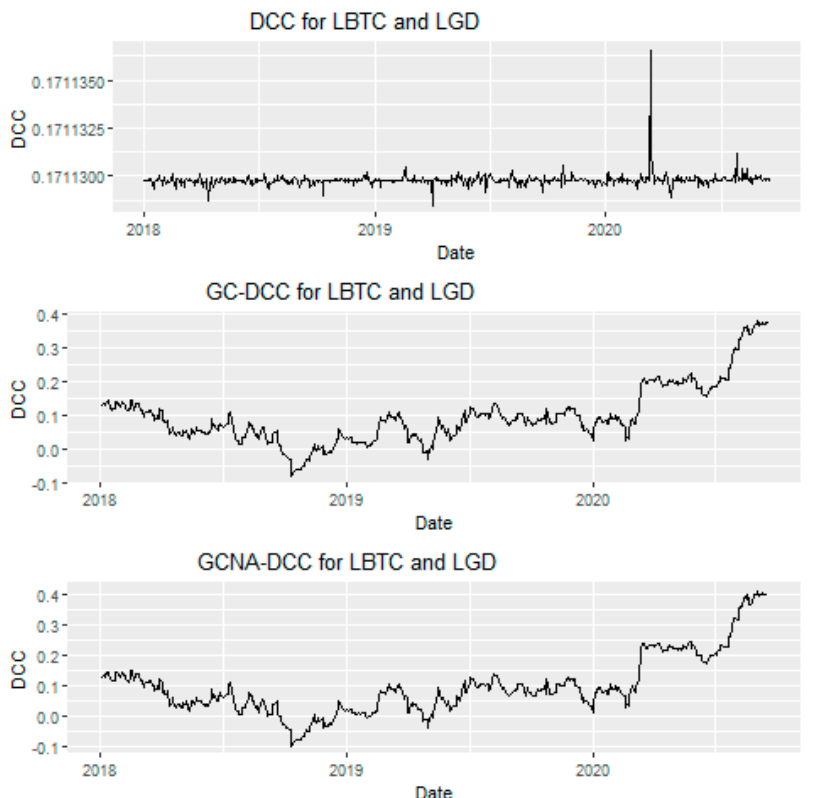
Figure 4. Dynamic conditional correlation between LBTC and LGD with GARCH-DCC (DCC), Gaussian copula-based GARCH-DCC (GC-DCC), and Gaussian copula-based Nonlinear Asymmetric GARCH-DCC (GCNA-DCC).